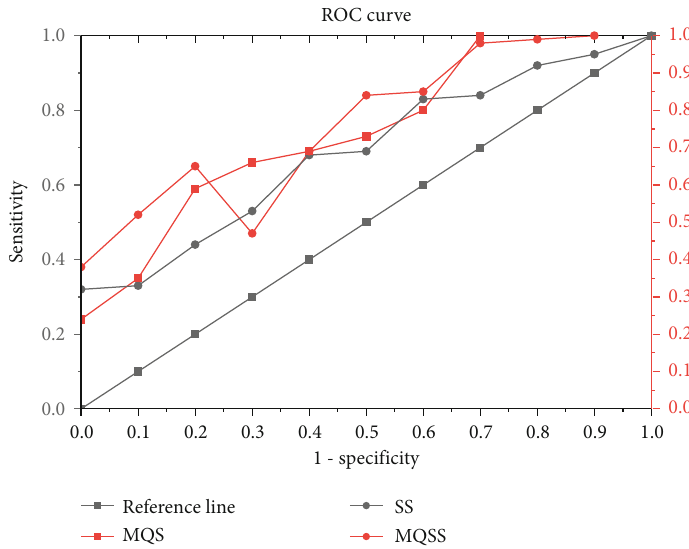
Figure 4: ROC curves of MQ and SS to distinguish the damage history of